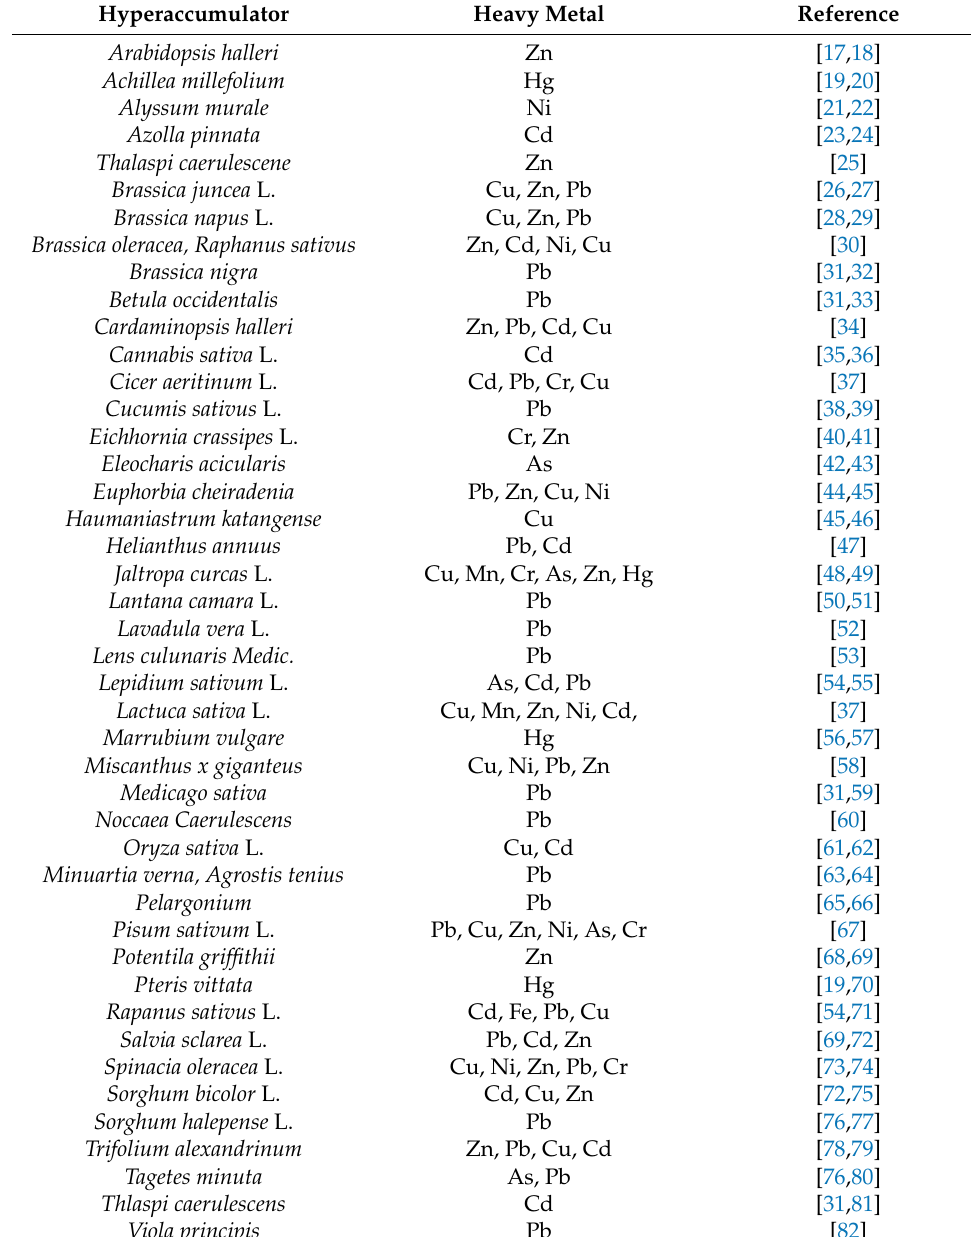
Table 1. Application of hyperaccumulators for removal of heavy metals from contaminated soils by